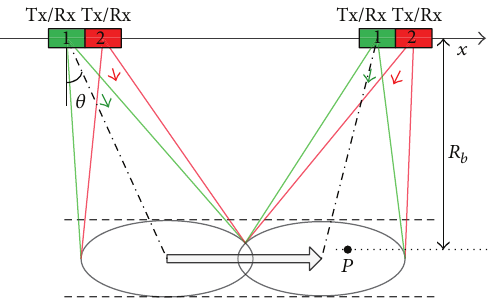
Figure 1: Imaging geometry of SF MIMO-SAR (sliding